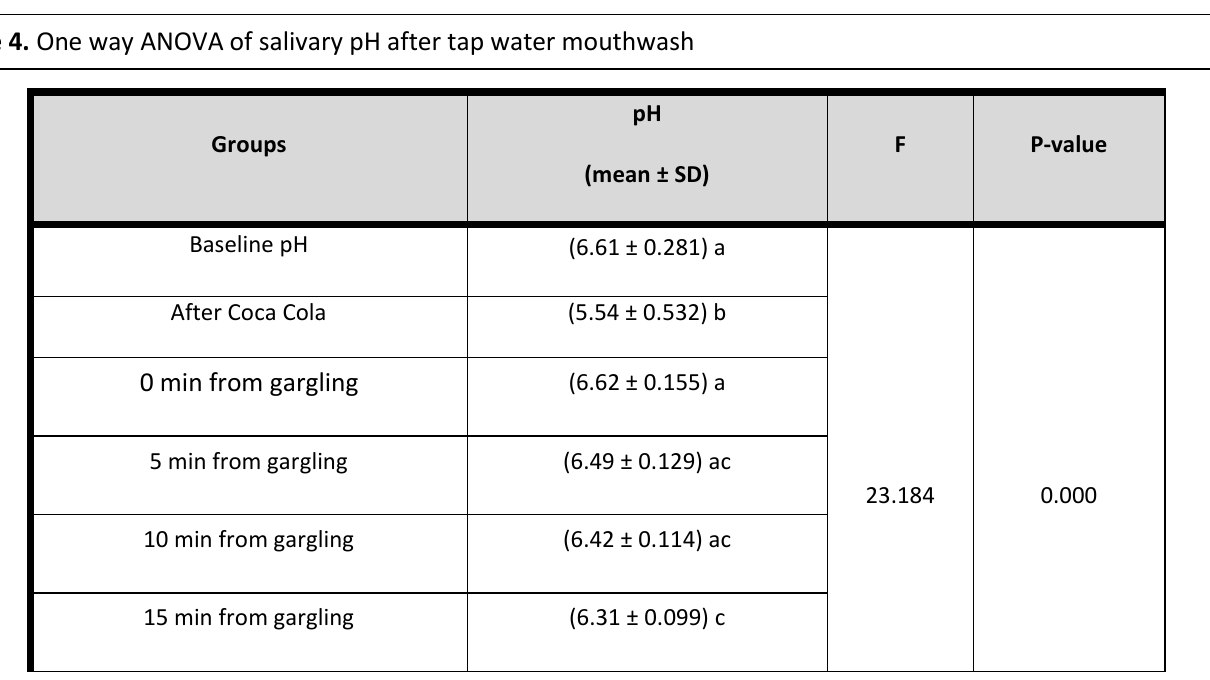
a: homogenous group, b and c: significant differences at p ≤